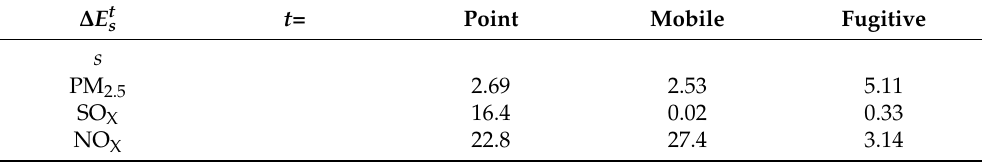
Figure 2. Spatial distribution of various pollutant emissions from point, mobile, and fugitive sources in KPAB. Table 1. Total emissions of pollutants from point, mobile, and fugitive sources in KPAB (10 3